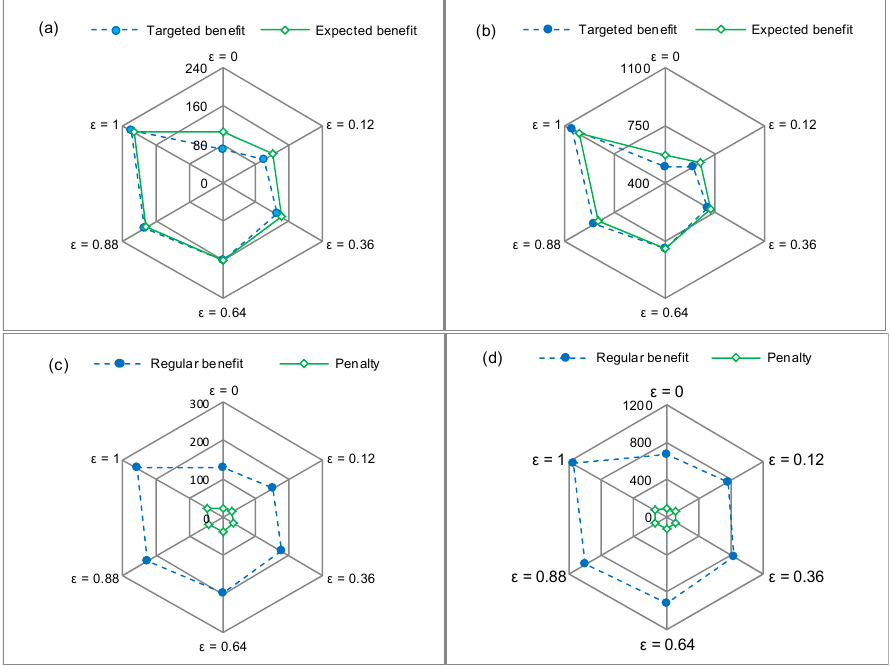
Figure 3. Benefits and costs under different risk levels. Note: ( a ) lower ‐ bound targeted benefit and system benefit, ( b ) upper ‐ bound targeted benefit and system benefit, ( c ) lower ‐ bound regular benefit and penalty, ( d ) upper ‐ bound regular benefit and penalty; unit: 10 6 RMB¥.